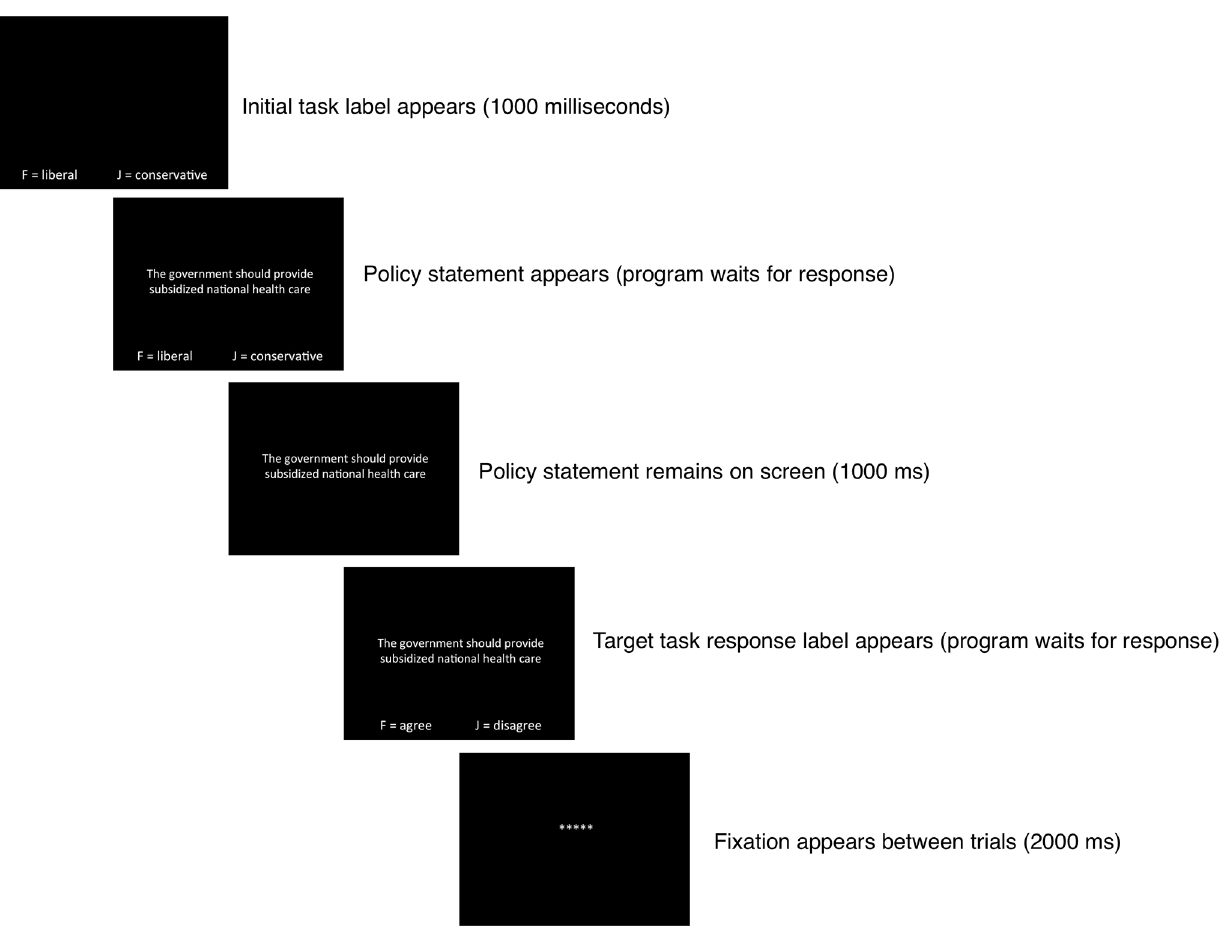
Figure 1. Example trial from Experiments 1 and 2. Trials were similar in Experiment 3 but the labels liberal and conservative were replaced with Democrat and Republican